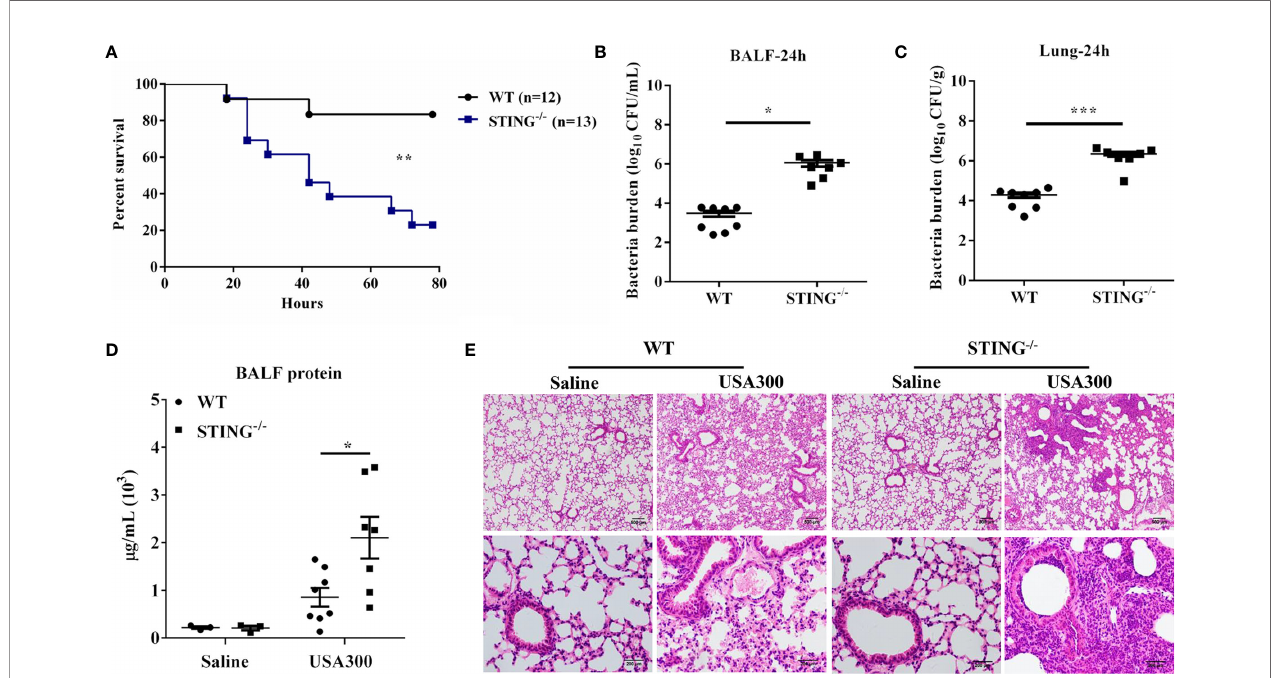
FIGURE 1 | STING-de fi cient mice display increased susceptibility to S.aureus pulmonary infection. WT and STING -/- mice were infected intranasally with S.aureus . (A) Survival was monitored up to 80 hpi (2 × 10 8 CFU, N = 12-13/group). WT and STING -/- mice (N = 7-8/group) were infected intranasally with a sublethal inoculum of S.aureus (1 × 10 8 CFU/mouse) for 24 h and then euthanized to quantitate the bacterial burden in (B) BALF, (C) lung. (D) Total protein in BALF was measured. (E) Lung tissue structures were observed by hematoxylin and eosin staining (magni fi cation of 100 × or 400 ×). All data are shown as mean ± SEM. Student ’ s t-test was performed. Log-rank test was used for statistical analysis of animal mortality. Statistical signi fi cance is indicated by *p < 0.05, **p < 0.01, and ***p <